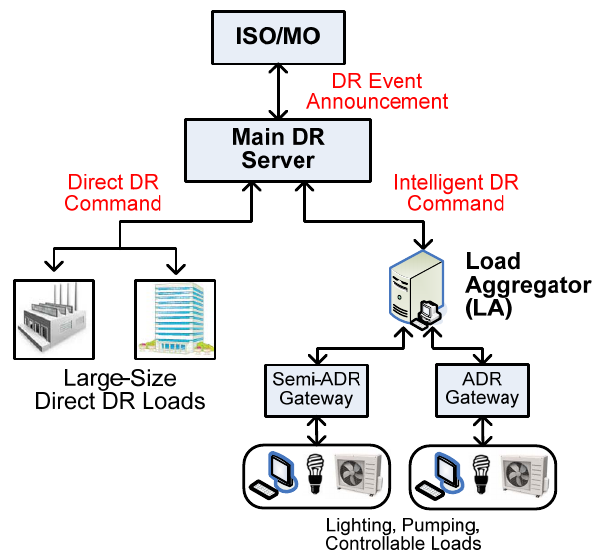
Figure 6. Conceptual diagram for KPX’s